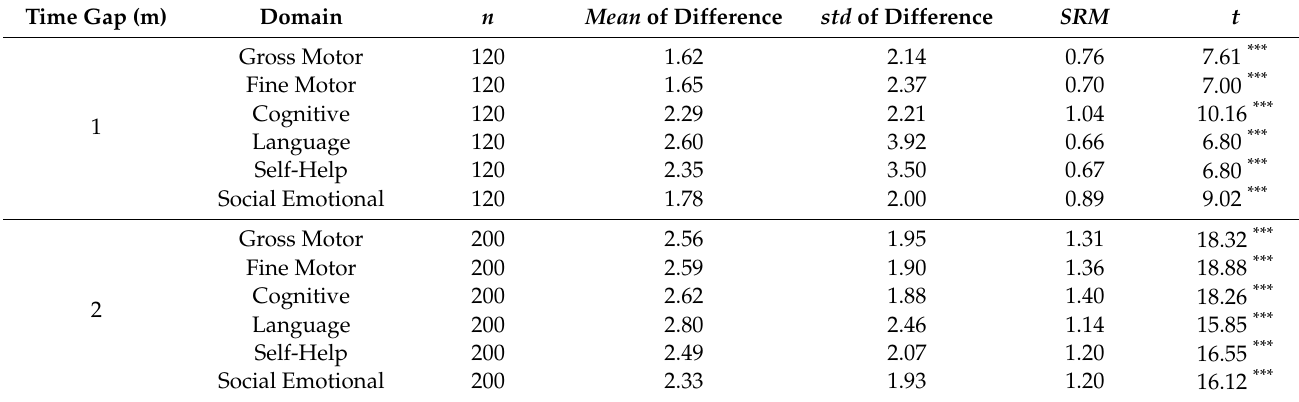
Table 11. Paired t- test result and standardized response mean ( SRM ) for children’s developmental age obtained from two tests with a time gap of 1–2